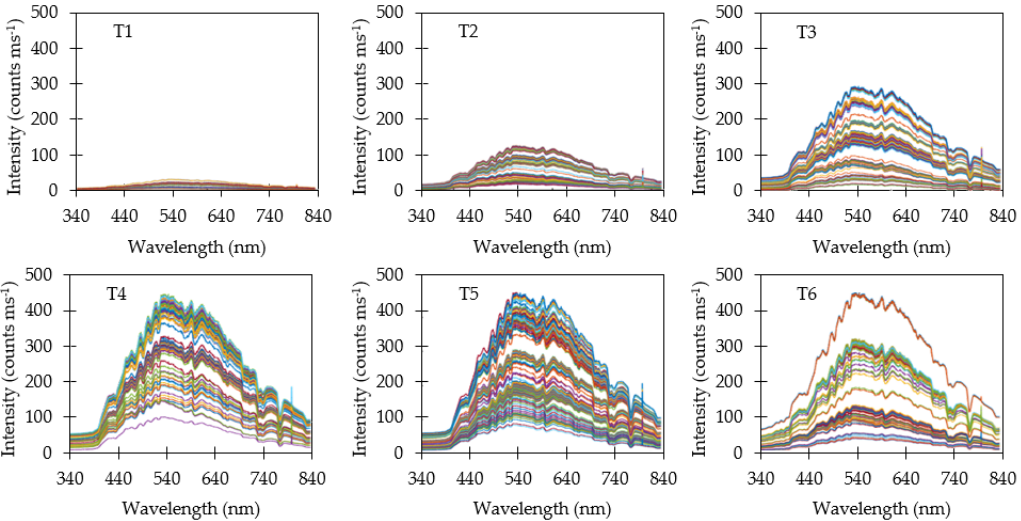
Figure 6. Reflectance measurements divided by integration time (M2). The resulting normalized spectra reveal the average intensity of the target for the three darkest targets (T1, T2 & T3) while the three brightest targets (T4, T5 & T6) still appear similar.